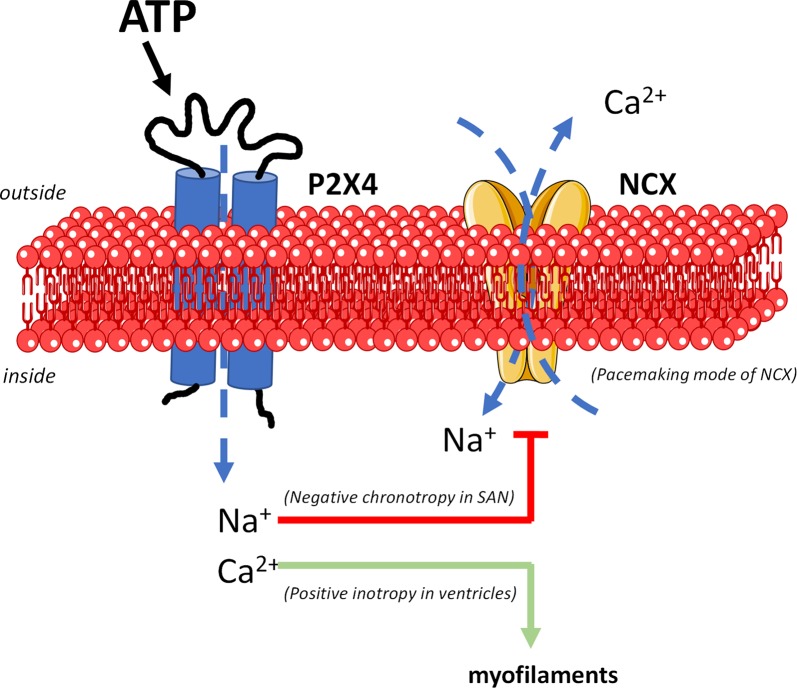
The mechanism underlying the dual P2X4 receptor-mediated effects on cardiac chronotropy and inotropy implicates downstream modulation of NCX activity (digitalis-like phenomenon). Besides ion fluxes carried by pacemaker HCN channels (not represented), the unstable resting membrane potential and the spontaneous firing of SAN cardiomyocytes are attributed mainly to the electrogenic NCX transport operating in the forward Ca2+-extrusion mode. Na+ influx through the P2X4 receptor pore dissipates the electrochemical gradient of this ion across the plasma membrane leading to inhibition and/or reversion of the NCX pacemaker current. This may justify slowing down of SAN cells depolarizations and the negative chronotropic effect of ATP. Likewise, intracellular Ca2+ accumulation due both (1) to Ca2+ influx through the P2X4 receptor pore, and (2) to reversal of NCX activity may explain the positive inotropic effect of the P2X4 receptor in paced ventricular cardiomyocytes. Figure composition used elements from Servier Medical Art.